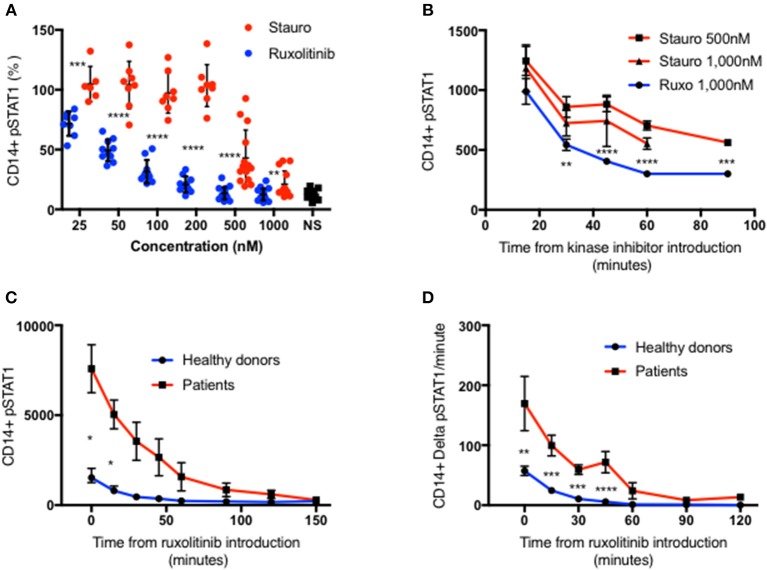
Ruxolitinib is more potent than staurosporine in inhibiting STAT1 phosphorylation. (A) Healthy donors CD14+ monocytes pSTAT1 level after 15′ of IFNγ stimulation with pre-incubation with a kinase inhibitor ruxolitinib (blue dots, n = 16) or staurosporine (red dot, n = 14) at increasing concentration (25–1,000 nM). Each individual's pSTAT1 level is expressed in percentage of the same healthy donor pSTAT1 level after 15′ of IFNγ stimulation, without pre-incubation with a kinase inhibitor. (B) CD14+ monocytes pSTAT1 level 15–90′ after introduction of staurosporine (500 or 1,000 nM) or ruxolitinib (1,000 nM) to healthy donors fresh PBMC stimulated with IFNγ for 15 min. Levels are expressed in geometric mean of fluorescence. (C) Average CD14+ monocytes pSTAT1 level of healthy controls (blue, n = 9) and patients (red, n = 3 with 1–3 repeated measurements per patient) over 2.5 h after introduction of ruxolitinib 1,000 nM to fresh PBMC, stimulated first with IFNγ for 15 min. Levels are expressed in geometric mean of fluorescence. (D) Average decrease per minute in CD14+ monocytes pSTAT1 level in healthy controls (blue, n = 9) and patients (red, n = 3) over 2 h after introduction of ruxolitinib 1,000 nM to fresh PBMC, stimulated first with IFNγ for 15 min. *P < 0.05; **P < 0.01; ***P < 0.001; ****P < 0.0001, by t-test. Quantitative data represent mean ± SEM.